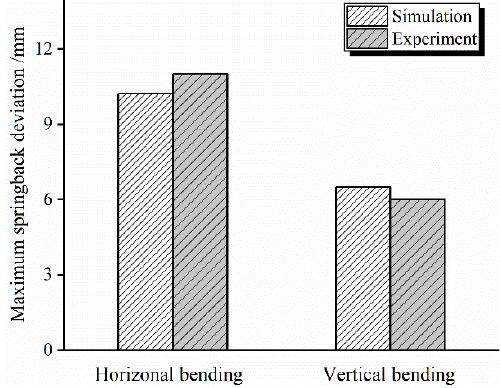
Figure 15. Comparison of maximum springback deviation.